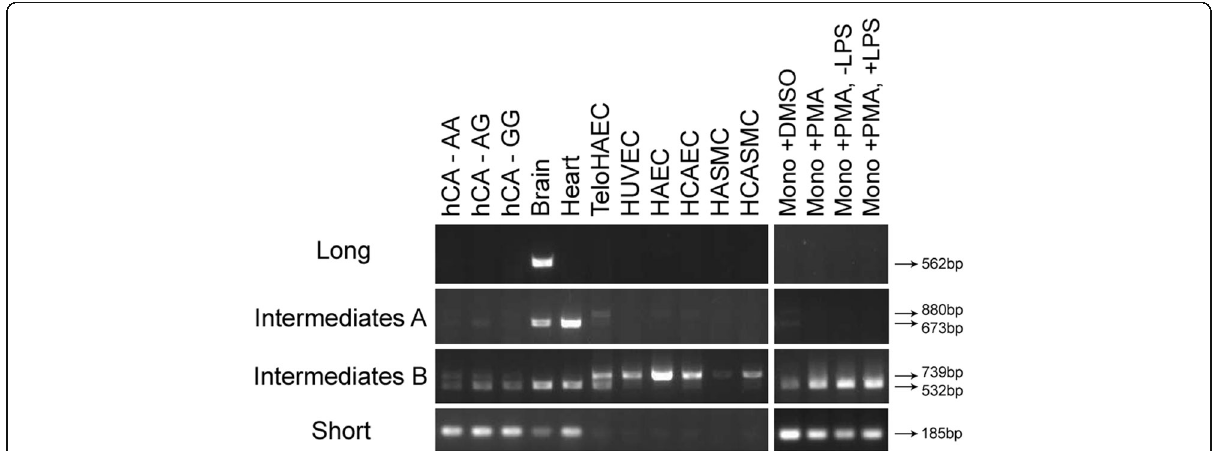
Fig. 2 PHACTR1 transcripts differential expression in human tissues and cell types. We designed transcript-specific primers and amplified PHACTR1 by RT-PCR. The PCR fragment for the long transcript is 562-bp. We did not amplify a 769-bp fragment using this set of primers, indicating that exon 10.11 is absent from the long transcript. The PCR fragments for the intermediate transcripts A+, A-, B+ and B- are 880-bp, 673-bp, 739-bp and 532-bp, respectively. The PCR fragment for the short transcript is 185-bp. HUVEC: human umbilical vein endothelial cell; teloHAEC: immortalized human aortic endothelial cells; HCASMC: human coronary artery smooth muscle cells; HAEC: human aortic endothelial cells; HCAEC: human coronary artery endothelial cells; HASMC: human aortic smooth muscle cells; Mono: monocytes; PMA: phorbol myristate acetate; LPS: